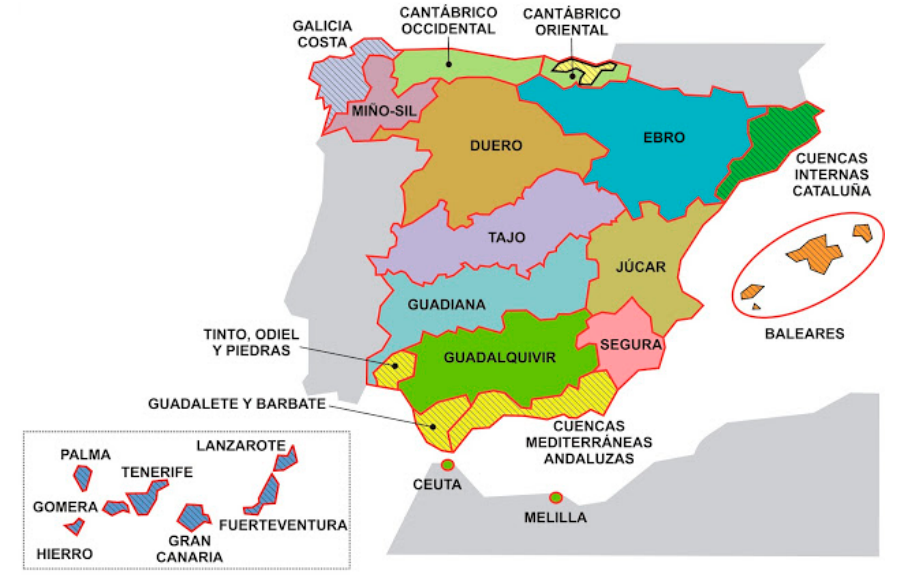
Figure 1. Location of inter ‐ regional and intra ‐ regional basins in Spain. Source: Adapted from [12].